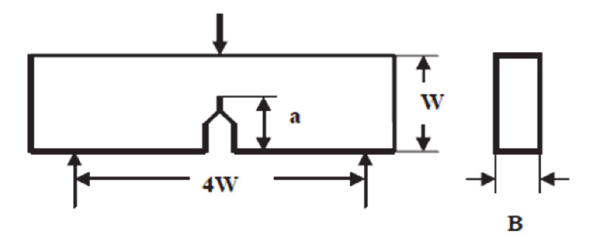
Figure 2: SENB specimen as per ASTM standard [14].